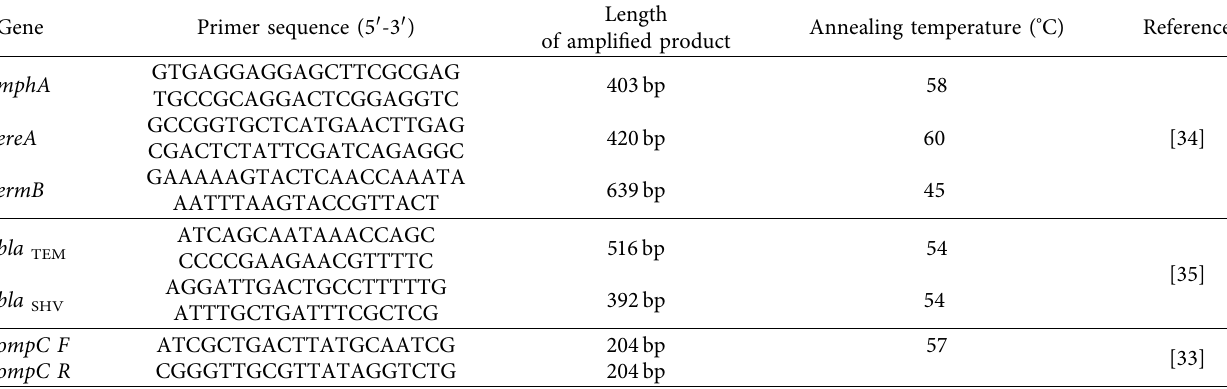
Table 1: Oligonucleotide primer sequences and their corresponding genes are used for the detection of antimicrobial-resistant genes in Salmonella